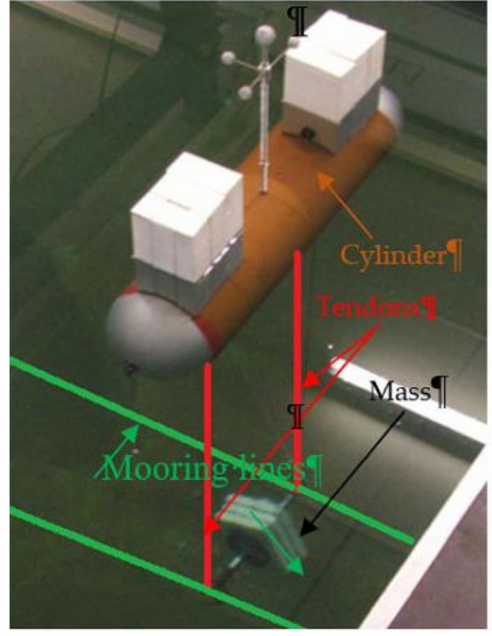
Figure 4. The examined WEC during